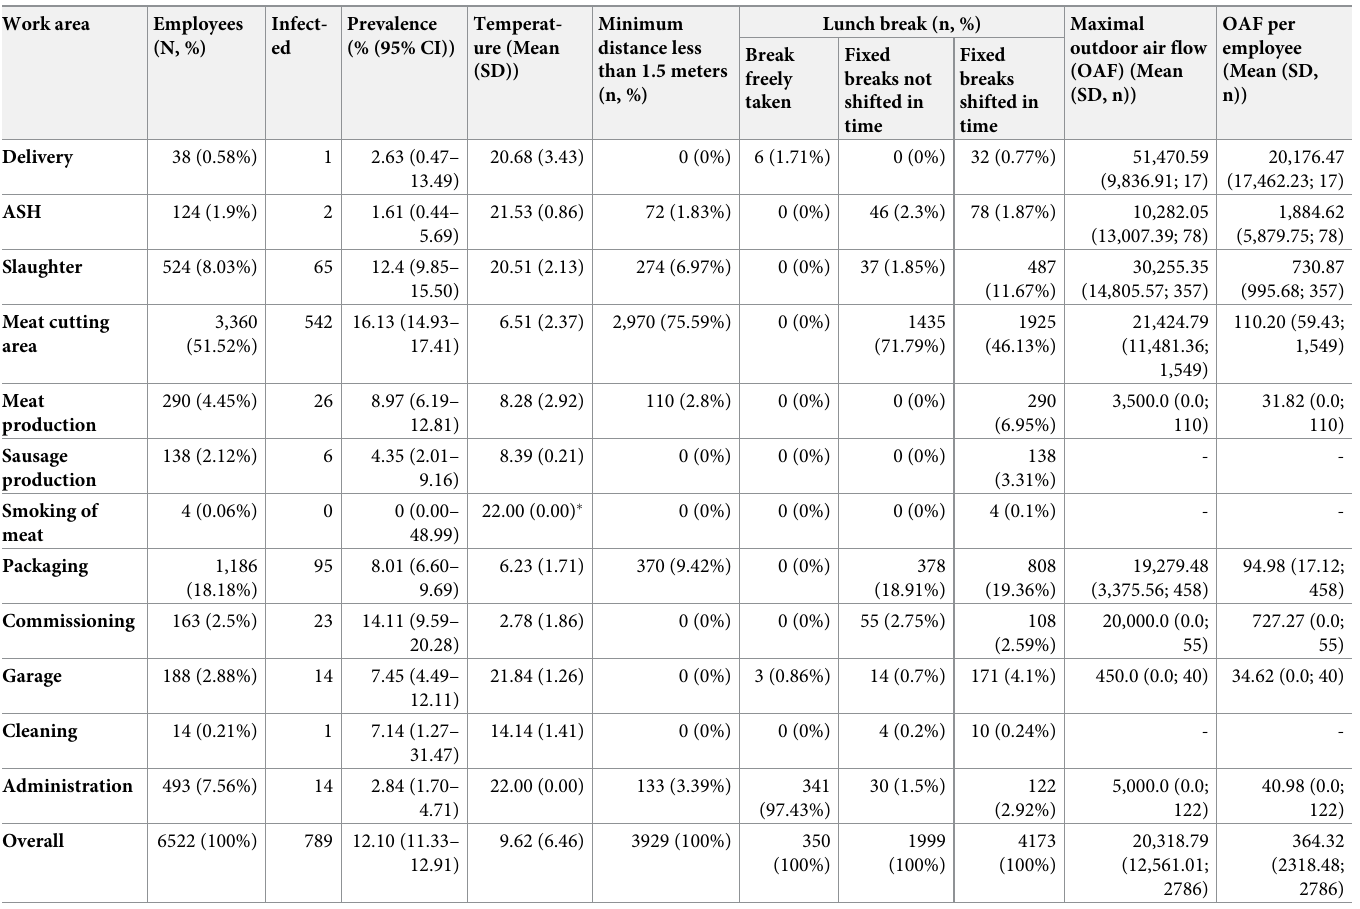
Table 4. Characteristics of the work areas in the plants with many infected